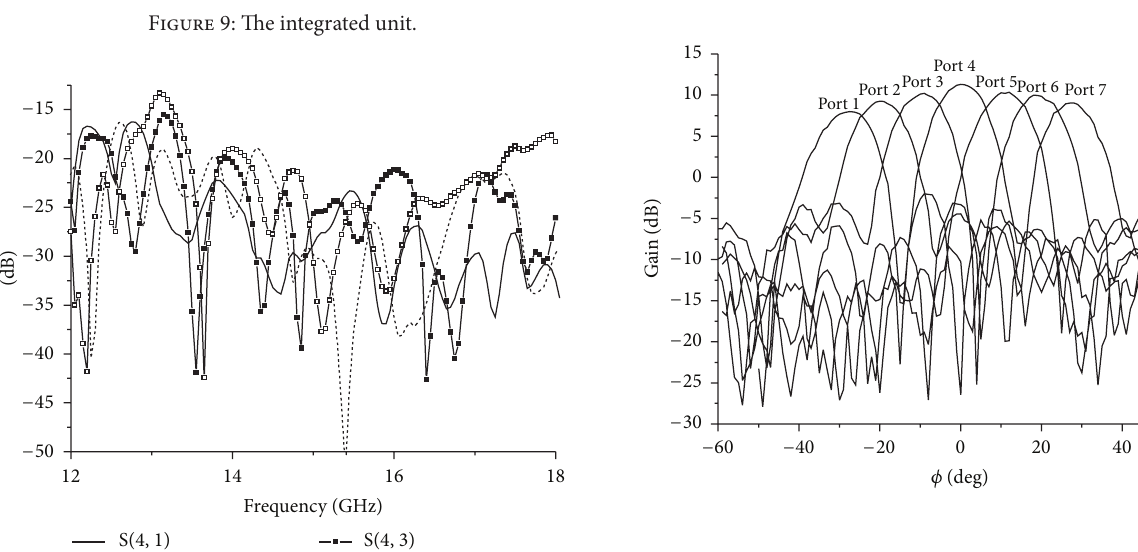
Figure 11: Reflection characteristics of Rotman lens beam ports.